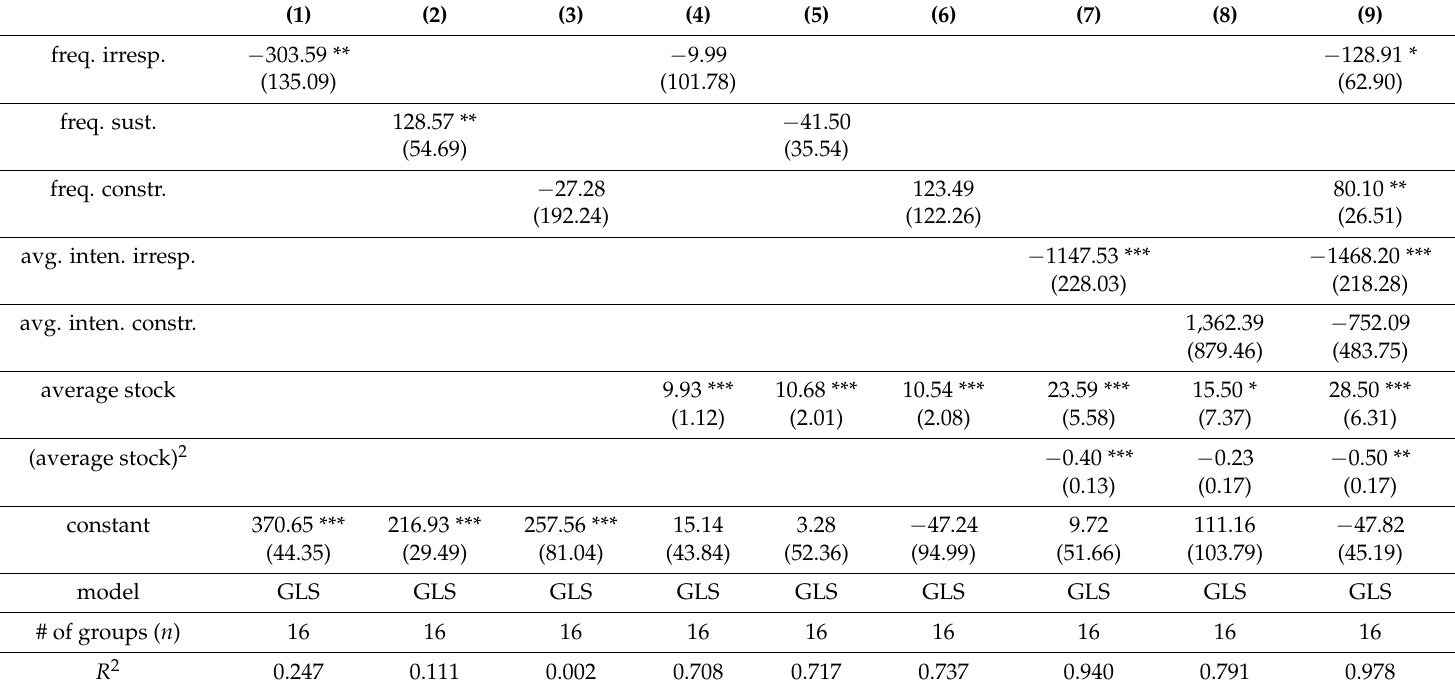
Table 3. Regressions of Group